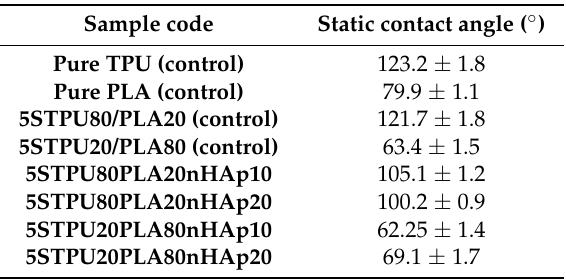
Table 7. Static water contact angle measurements for different TPU/PLA/nHAP nanocomposite and TPU/PLA blend surfaces.